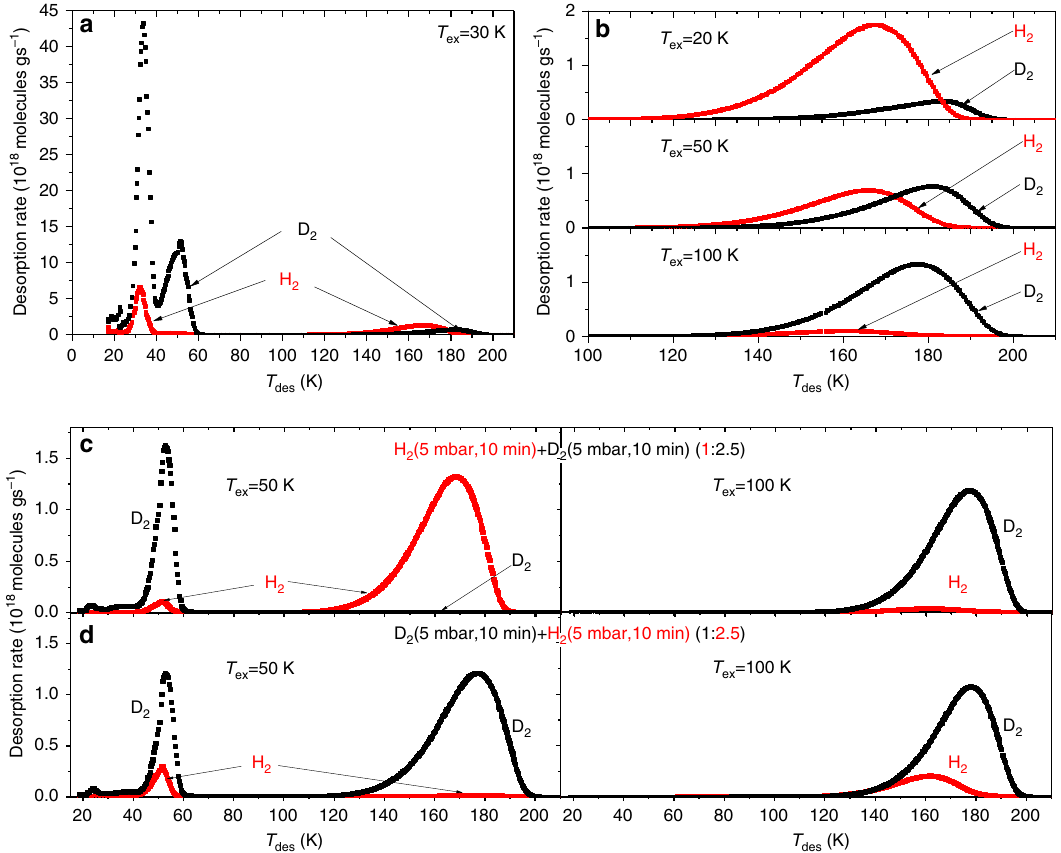
Figure 2 | Thermal desorption spectra of adsorbed H 2 and D 2 . TDS spectra after exposure to a 10mbar 1:1 H 2 (red)/D 2 (black) mixture for 10min at different exposure temperatures T ex , showing the whole ( a ) and high-temperature ( b ) range. Stepwise loading at T ex =50 and 100K: first H 2 (5mbar, 10min), then 5mbar of D 2 was added for another 10min ( c ) and reverse loading sequence ( d